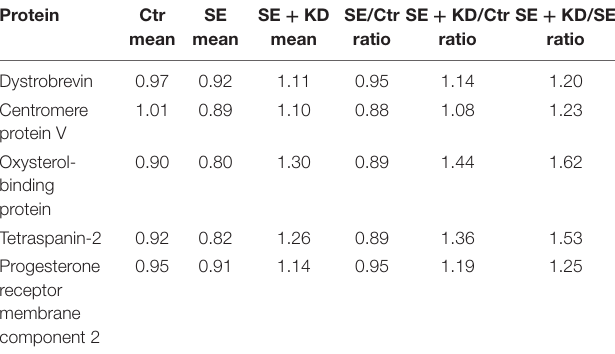
TABLE 3 | Quantitative analysis of target protein